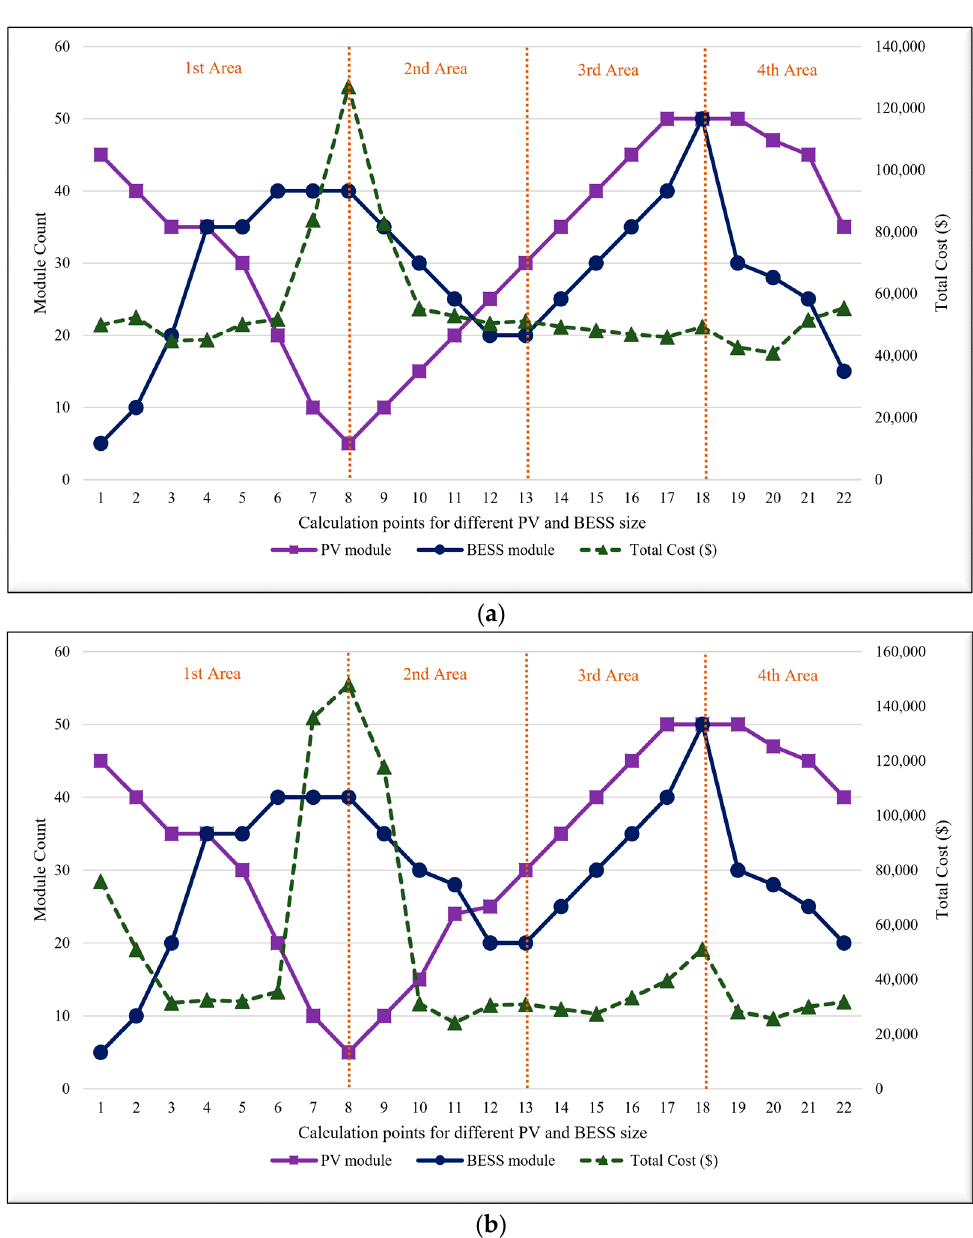
Figure 7. System total cost for various PV and BESS module combinations: ( a ) case 1; ( b ) case 2.